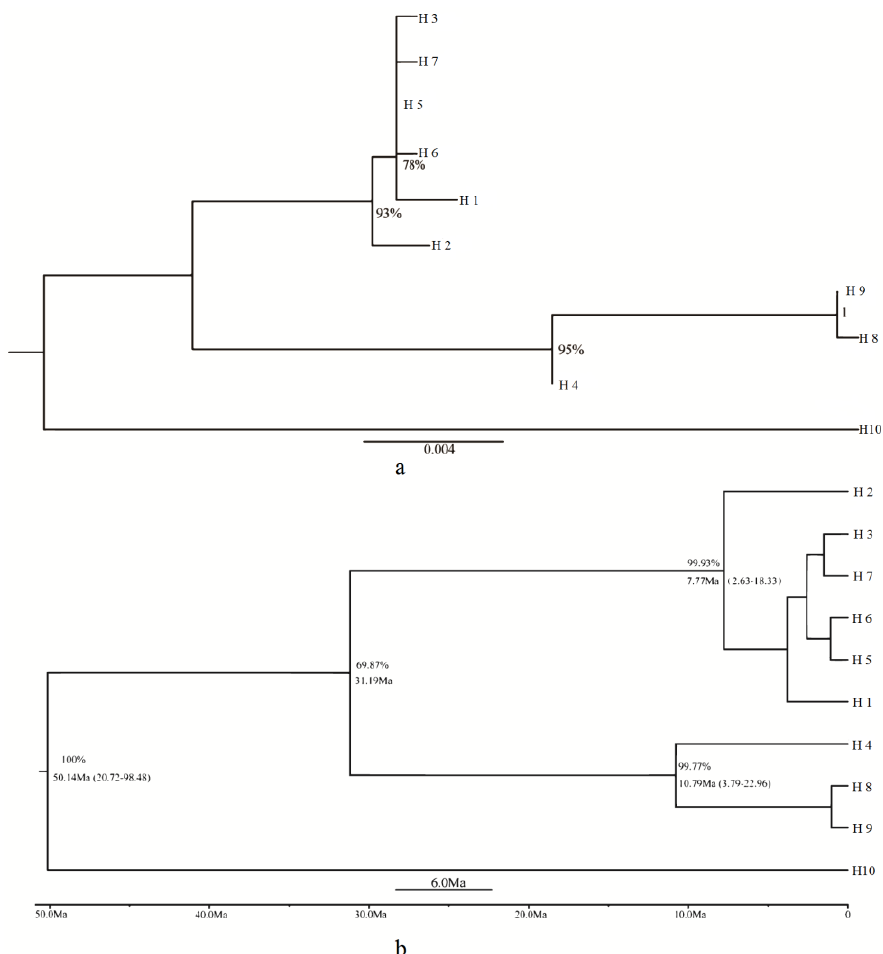
Figure 4. ( a ) Phylogenetic tree (ML) of the nine chloroplast haplotypes detected in Dipteronia Oliv. with H10 as the outgroup using Acer miaotaiense. ( b ) Beast-derived chronogram for the haplotypes in Dipteronia Oliv. based on four chloroplast DNA spacer regions. Posterior probabilities above 0.95 are shown above nodes. Error bars around nodes correspond to 95% highest posterior densities of divergence times. H10 marks the outgroup using Acer miaotaiense.